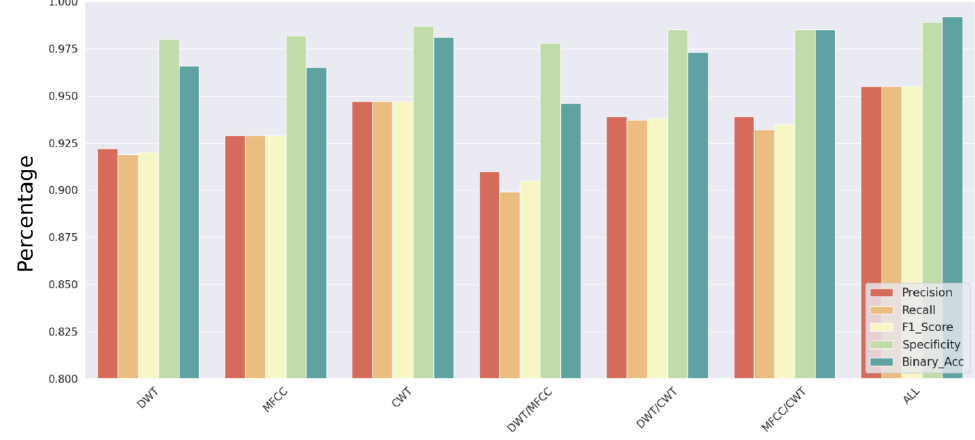
Figure 9. Precision, recall, F1 score, specificity, and accuracy of each proposed model.